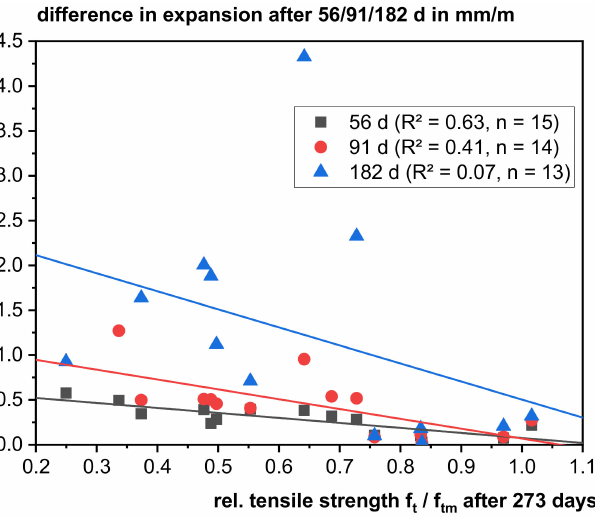
Figure 6. Correlation of the difference in expansion (SVA method, 30,000 mg SO 42 − /L, 20 ◦ C) over the course of time and the relative tensile strength f t /f tm after 273 days.